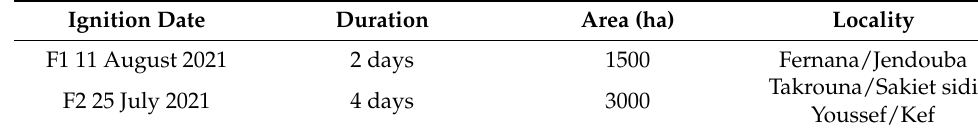
Table 1. Locations, ignition dates and extent of forest fires considered in this study.